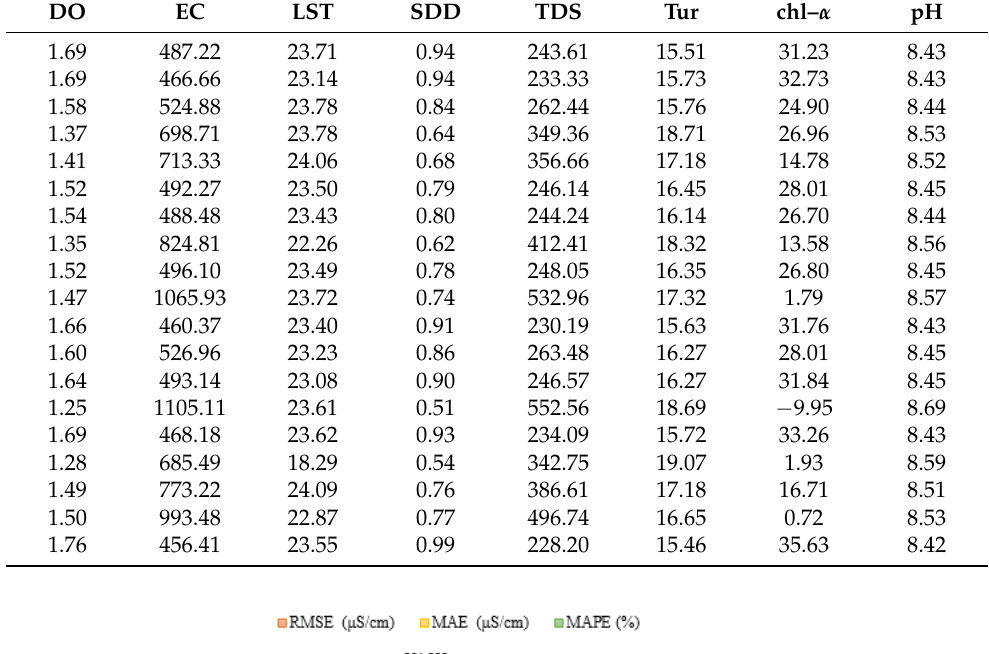
Table 3. Last 20 water quality samples extracted from LANDSAT 8 images for September 2021.